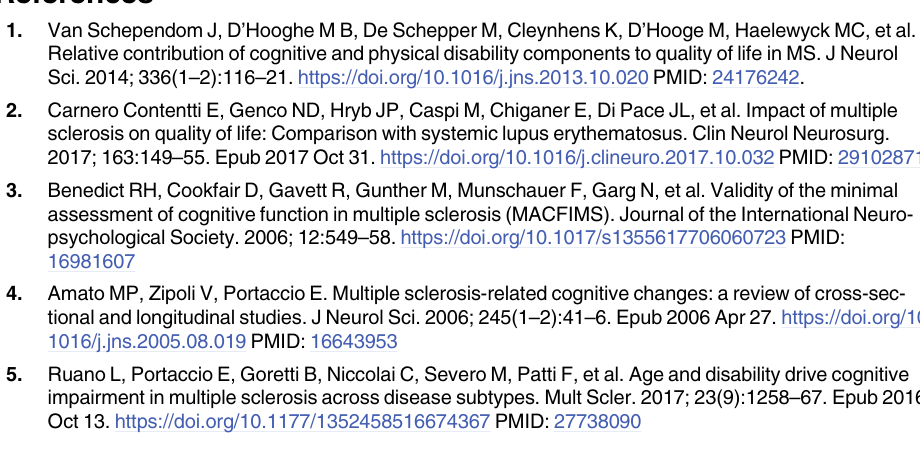
S2 Fig. Progression scenario 1. Area under the ROC curve for measures 1–3 (M M ), nine time points. 3 (TIF) S3 Fig. Progression scenario 2. Area under the ROC curve for measures 1–3 (M M ), nine time points. 3 (TIF) S1 Text. Development of